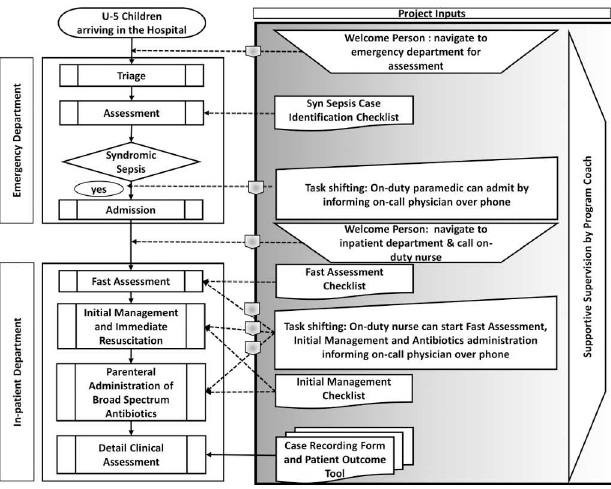
Fig 1. Operational flow and guideline of managing syndromic